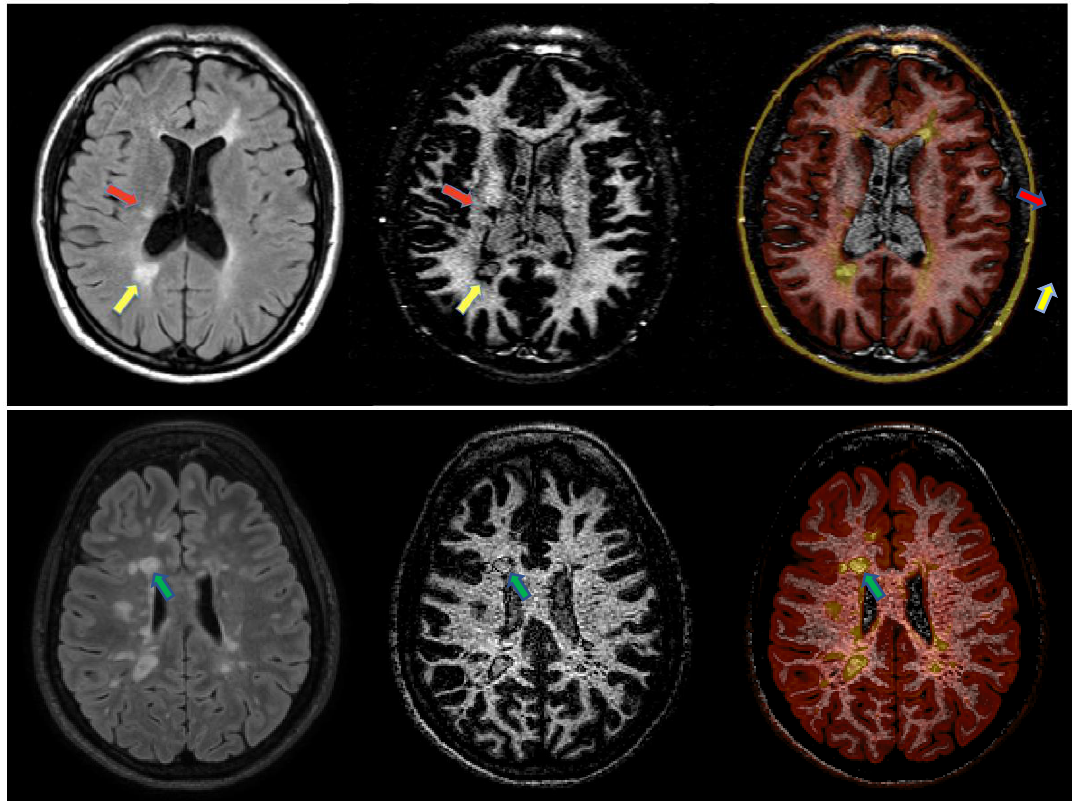
Figure 1. The first row describes the visualization, at 1.5 T, of a typical MS WM lesion on fluid attenuated inversion recovery (FLAIR) ( left ), characteristically surrounded by a dark rim (DRL) on a white-matter selective double inversion recovery sequence (WM-DIR) (middle, yellow arrow); a uniform hypointensity on WM-DIR (no-DRL) characterizing another WM lesion can be observed (red arrow). On the right an example of a color-coded FLAIR–WM-DIR fusion image to show where the “dark rim” is exactly located with respect to the FLAIR-visible contours. The second row shows a 3T example of DRL (green arrow) on WM-DIR (middle), FLAIR (left), and FLAIR-WM-DIR fusion ( right ). The cortical thickness was calculated using FreeSurfer, a software based on a T1- weighted image (using a semi-automatic procedure with lesions filling to correct topological defects in the cortical surface due to juxtacortical lesions. Cortical lesions were evaluated on conventional DIR sequences following the consensus of recommendations